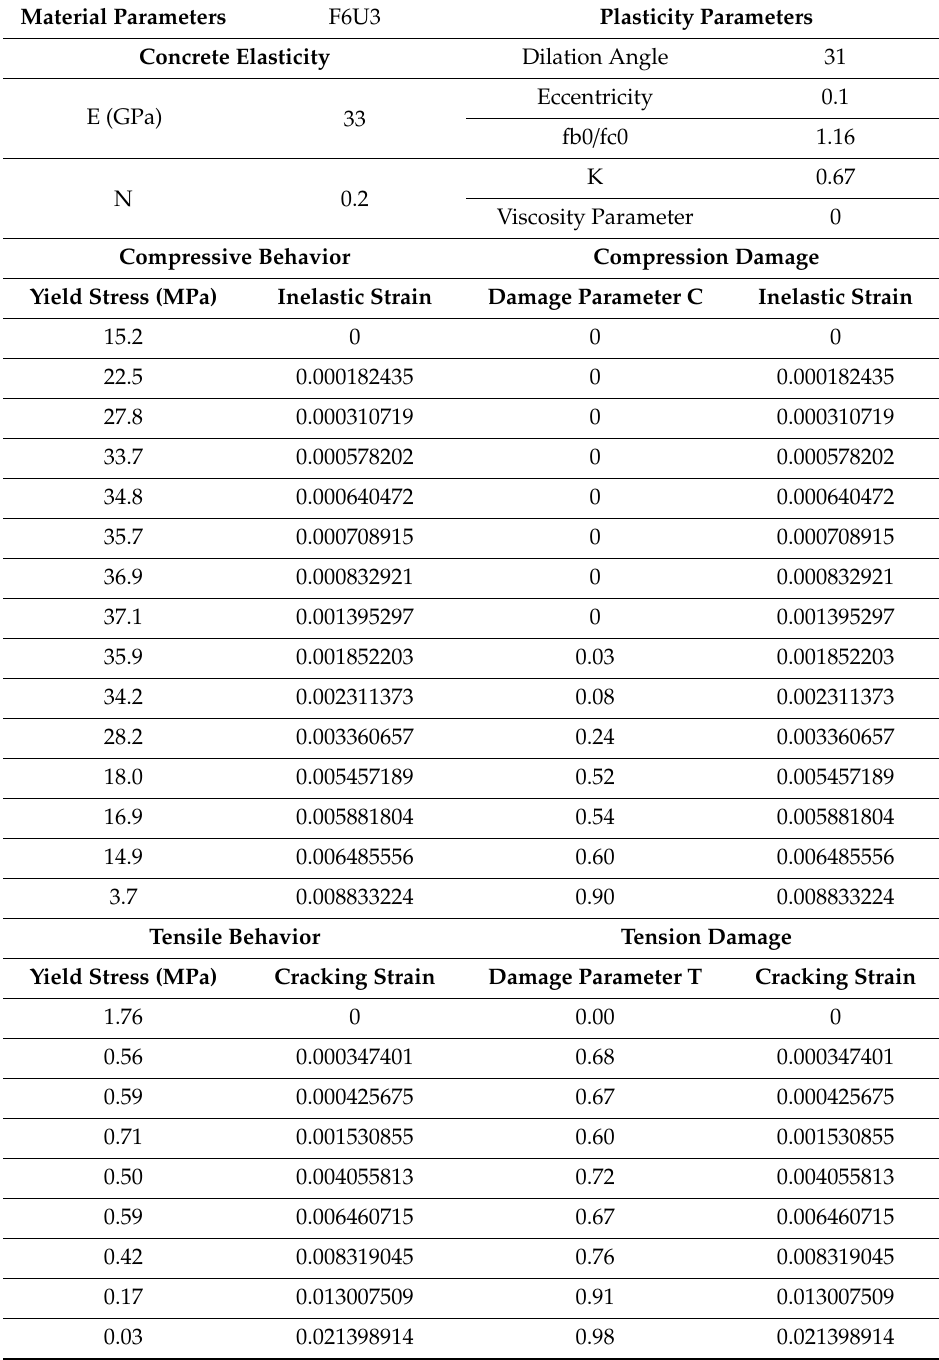
Table 8. Material properties of F6U3